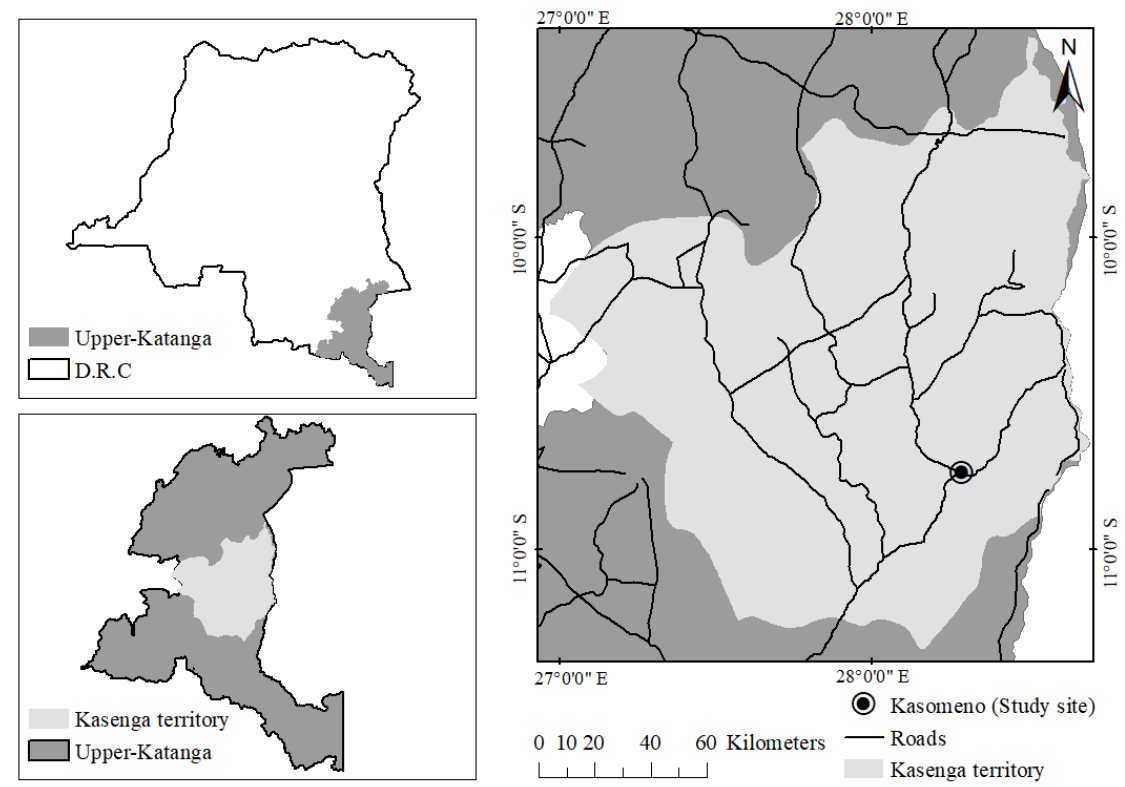
Figure 1. Geographical location of the study site (Kasomeno and its peripheral zone) in the southeast of the province of Haut-Katanga in D.R.